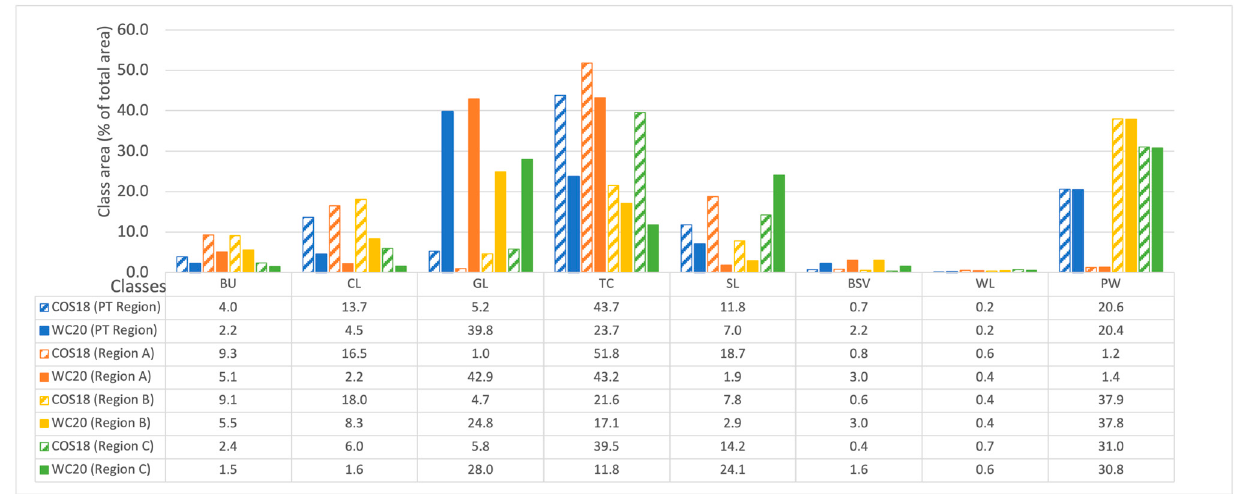
Figure 5. Percentage of class area coverage for WC20 and COS18 for continental Portugal (PT Region) and regions A, B and C.